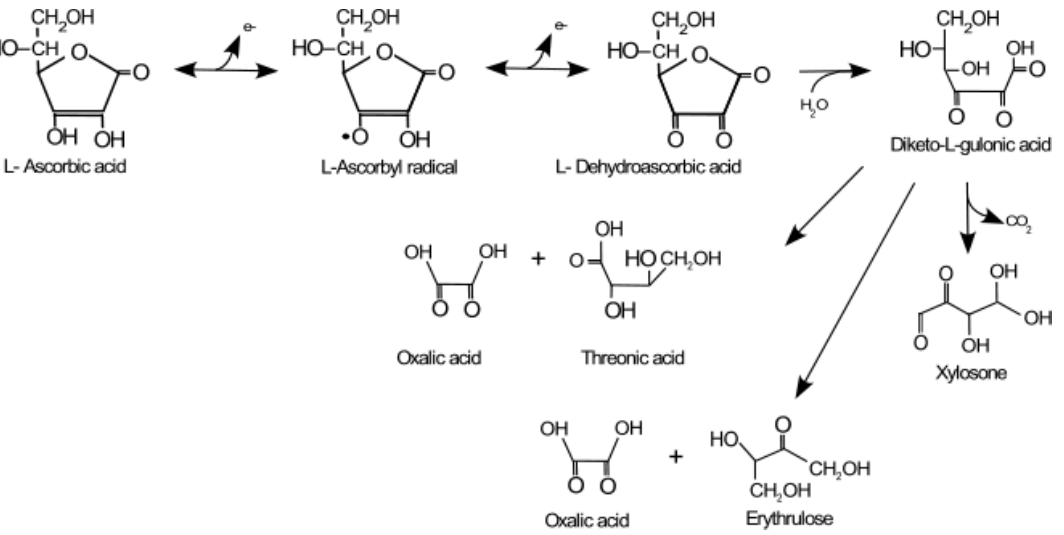
Figure 1. Vitamin C metabolism. In humans, AA is oxidized and degraded into 2–4 carbon products. Translated and modified from Villagran et al. [9].